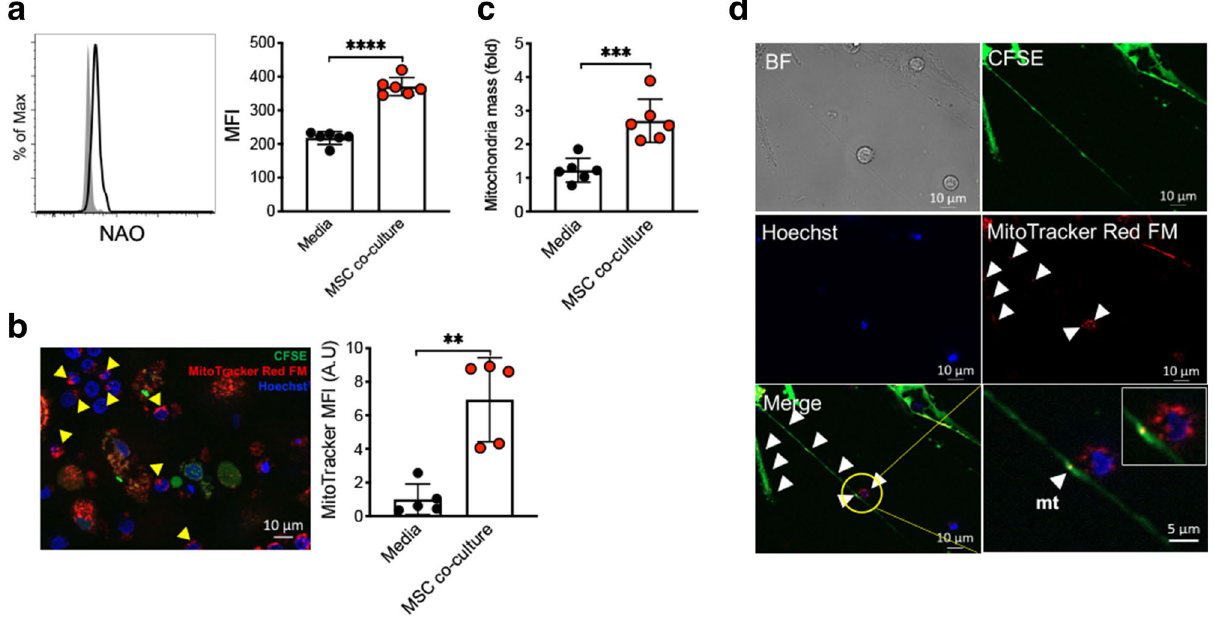
Figure 3. MSC mitochondrial transfer to iTregs occurs via TNT. ( a ) Mitochondrial quantity assay of iTregs was analyzed. At 3 weeks, media vs MSC co-culture iTreg cells were stained with NAO to quantify mt mass ( n = 5). ( b ) Confocal imaging analysis for MitoTracker transfer. MSC were stained with CFSE (green) and MitoTracker Far Red (red), iTreg were stained with Hoechst (blue) and then co-cultured for 24–36 h ( n = 5). ( c ) Mitochondria DNA copy number was assessed from IL-2/media or MSC co-culture expanded iTregs at day 21 ( n = 6). ( d ) MSC mt transfer analysis. MSC were stained with CFSE (green) and MitoTracker Far Red (red), iTreg were stained Hoechst (blue) and cells were co-cultured for 24–36 h. Live cell images were collected by confocal microscopy. Data are representative of three independent experiments. ( b , d ) Analysis of recorded images was performed using Zen software Blue edition, (2011; version 2.0.14283.302). https:// www. zeiss. com/ micro scopy/ us/ produ cts/ micro scope- softw are/ zen. html ** p < 0.01, *** p < 0.001, **** p < 0.0001 paired t test. Scale bars: 10 μm. See also Supplementary Fig.